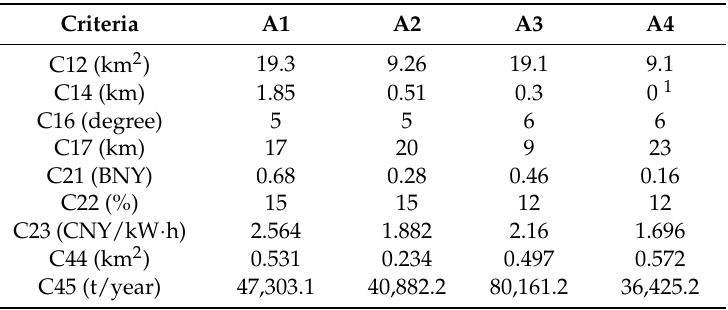
Table 4. The decision data of the criteria which forms are real numbers.